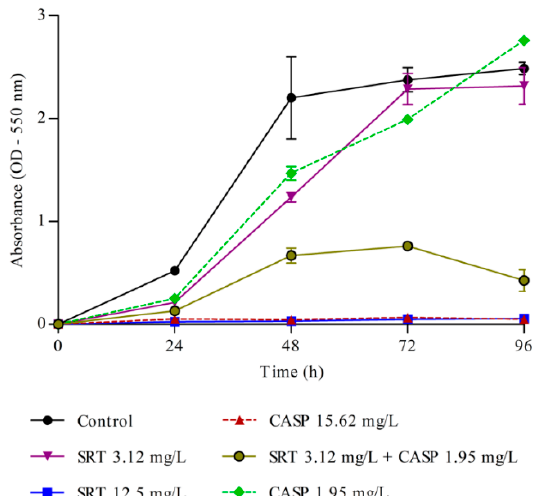
Figure 3. Metabolism of T. rubrum biofilm. Effects of sertraline (SRT), caspofungin (CASP), and SRT + CASP on the metabolic activity of T. rubrum